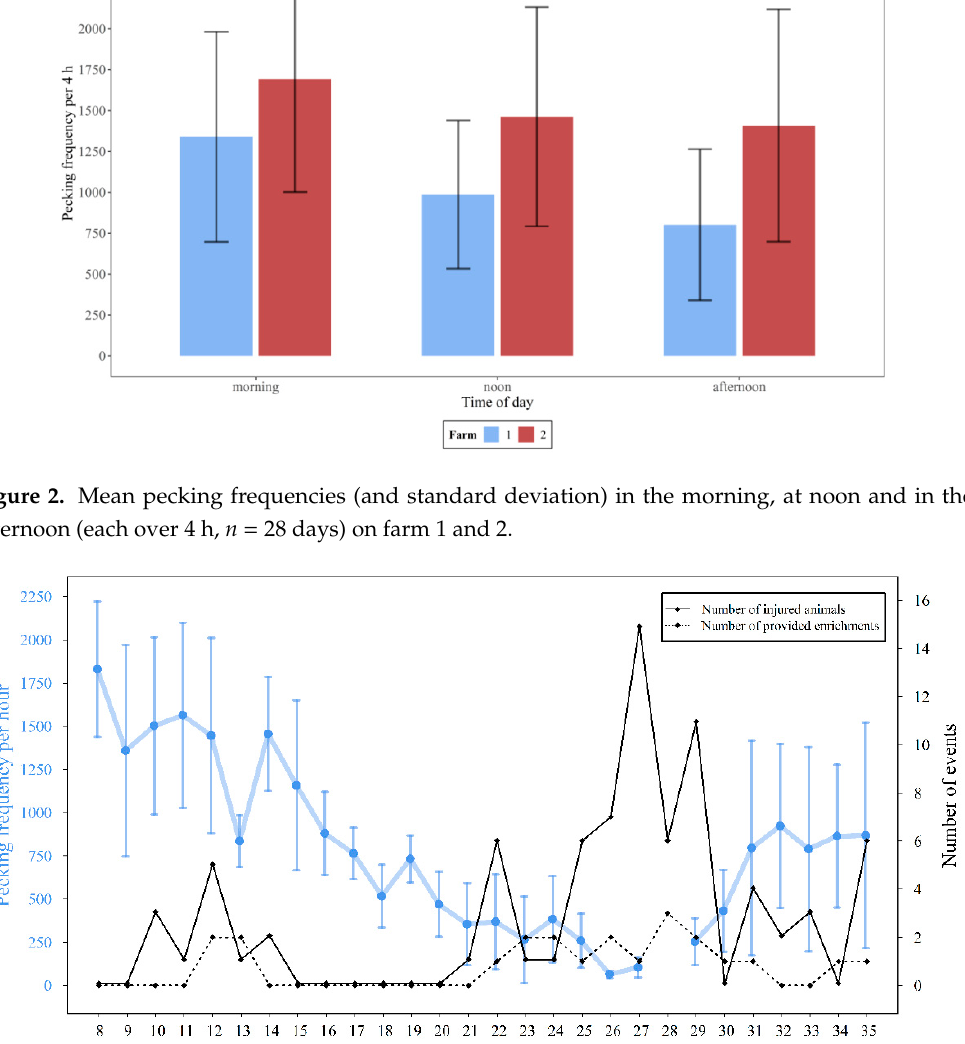
Figure 2. Mean pecking frequencies (and standard deviation) in the morning, at noon and in the afternoon (each over 4 h, n = 28 days) on farm 1 and 2.